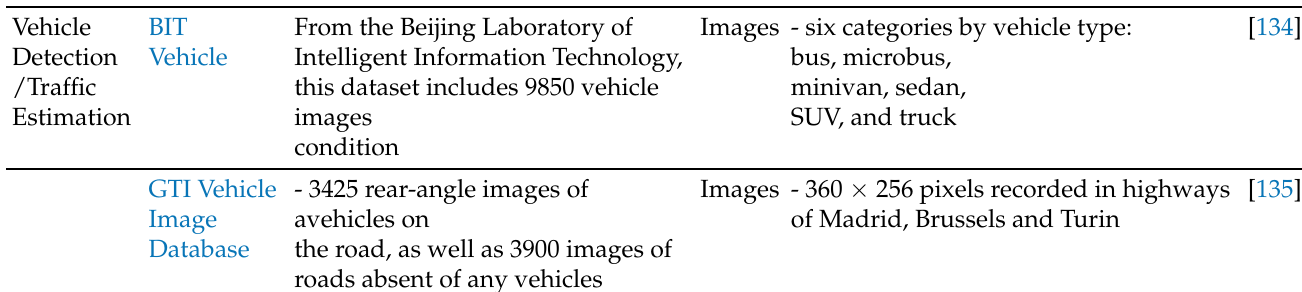
Table 12. Frequently used datasets.